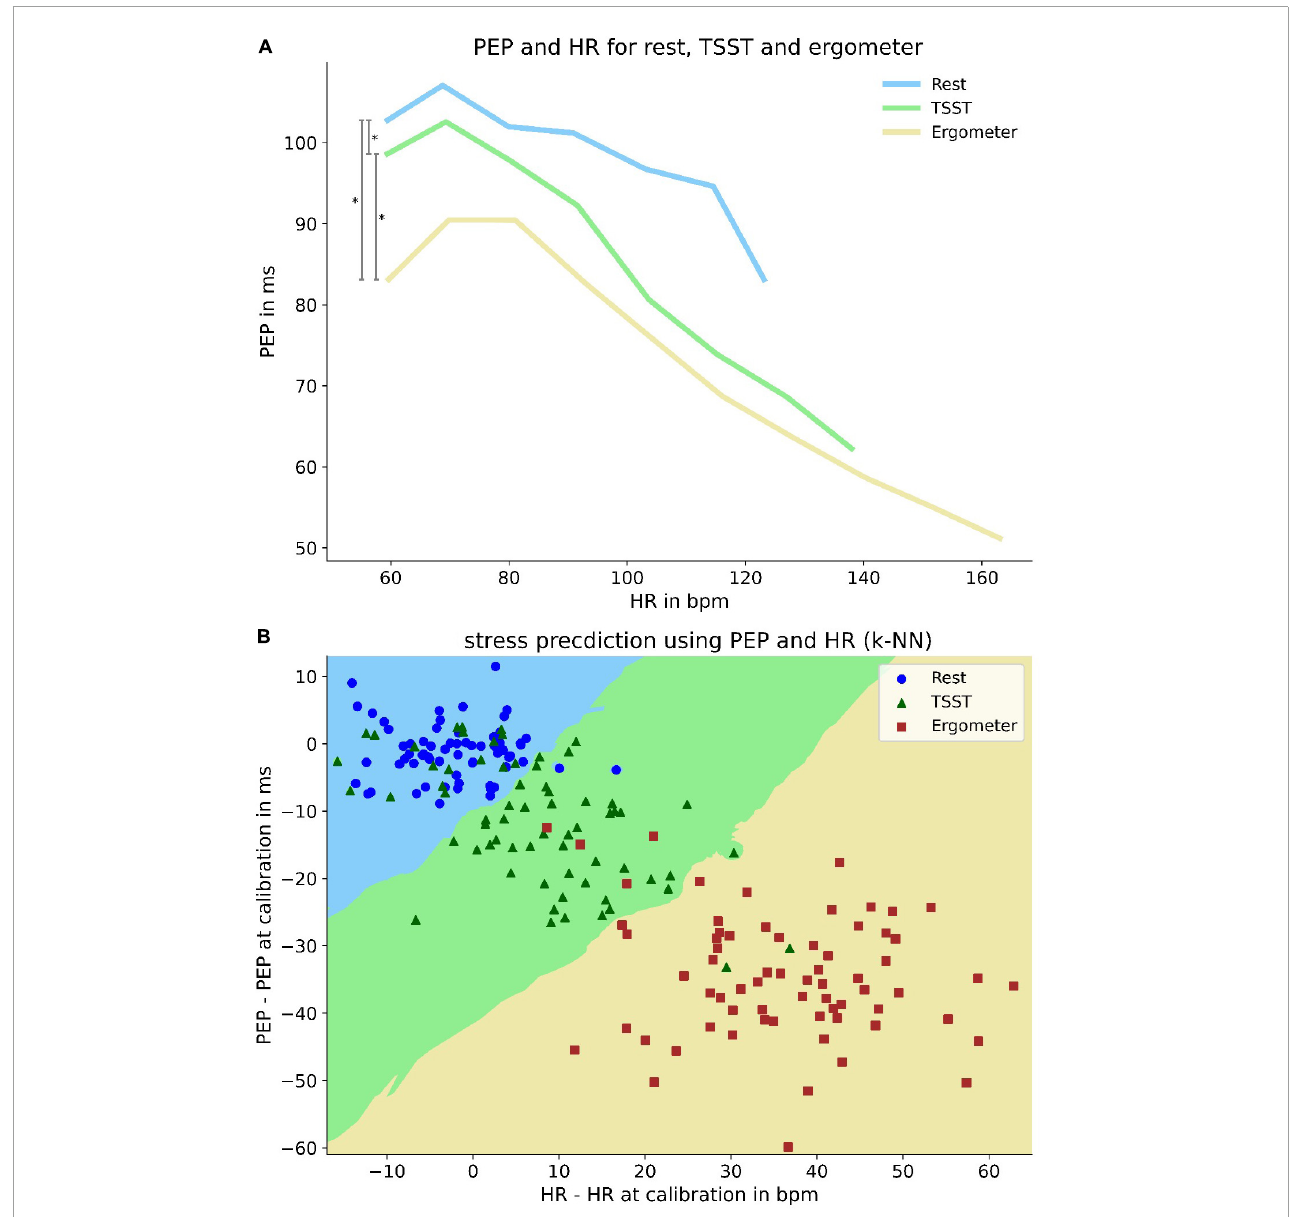
FIGURE7 Differences of PEP at same heart rate and its predictive power for current load. Upper panel (A) : Differences of PEP at same heart rates at rest and under mental and physical load. To enhance visibility, PEP values are averaged over a heart rate range of 12 bpm. Lower pane (B) l: k-nearest-neighbor predictor ( k = 13) of load-state based on heart rate and PEP deviation from measurement at rest. Decision boundaries are marked by colored areas in the plot. Bisecting decision boundaries represent a coequal importance of PEP and HR for predictive power (e.g., solely heart rate based predictor would show vertical decision boundaries). Scattered elements represent patient specific mean values under rest (blue circle), mental (green triangle) and physical load (red